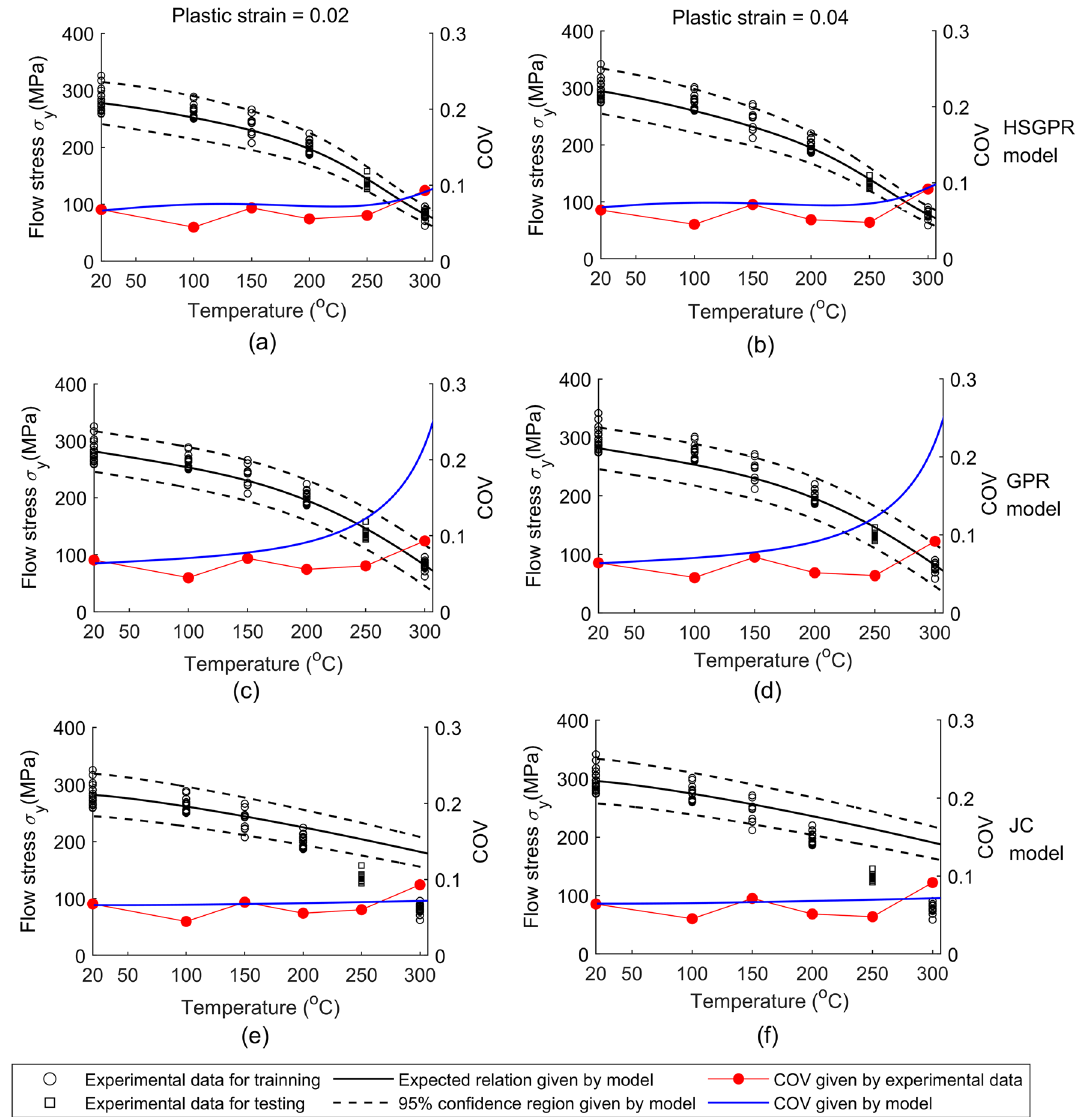
Figure 4. The obtained HSGPR-based flow stress model, GPR-based flow stress model and JC model with respect to the temperatures at the plastic strains of 0.02 and 0.04. ( a ) HSGPR model at the plastic strains of 0.02, ( b ) HSGPR model at the plastic strains of 0.04, ( c ) GPR model at the plastic strains of 0.02, ( d ) GPR model at the plastic strains of 0.04, ( e ) JC model at the plastic strains of 0.02, ( f ) JC model at the plastic strains of